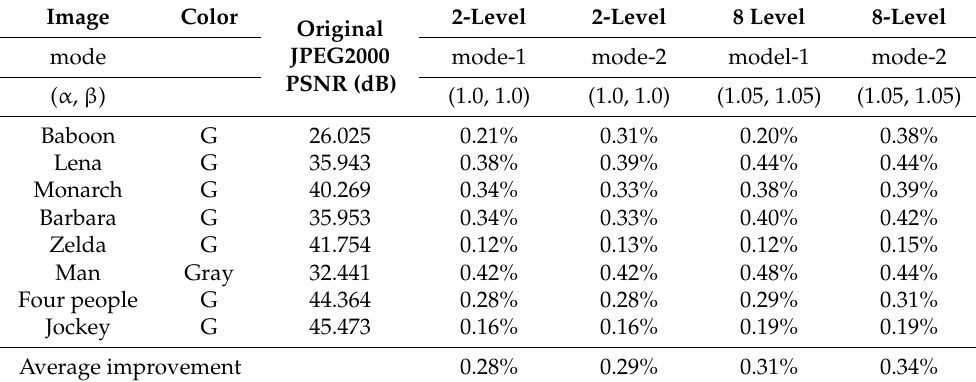
Table 19. Improvement percentage of PSNR with proposed algorithm applying multi-level MQ in